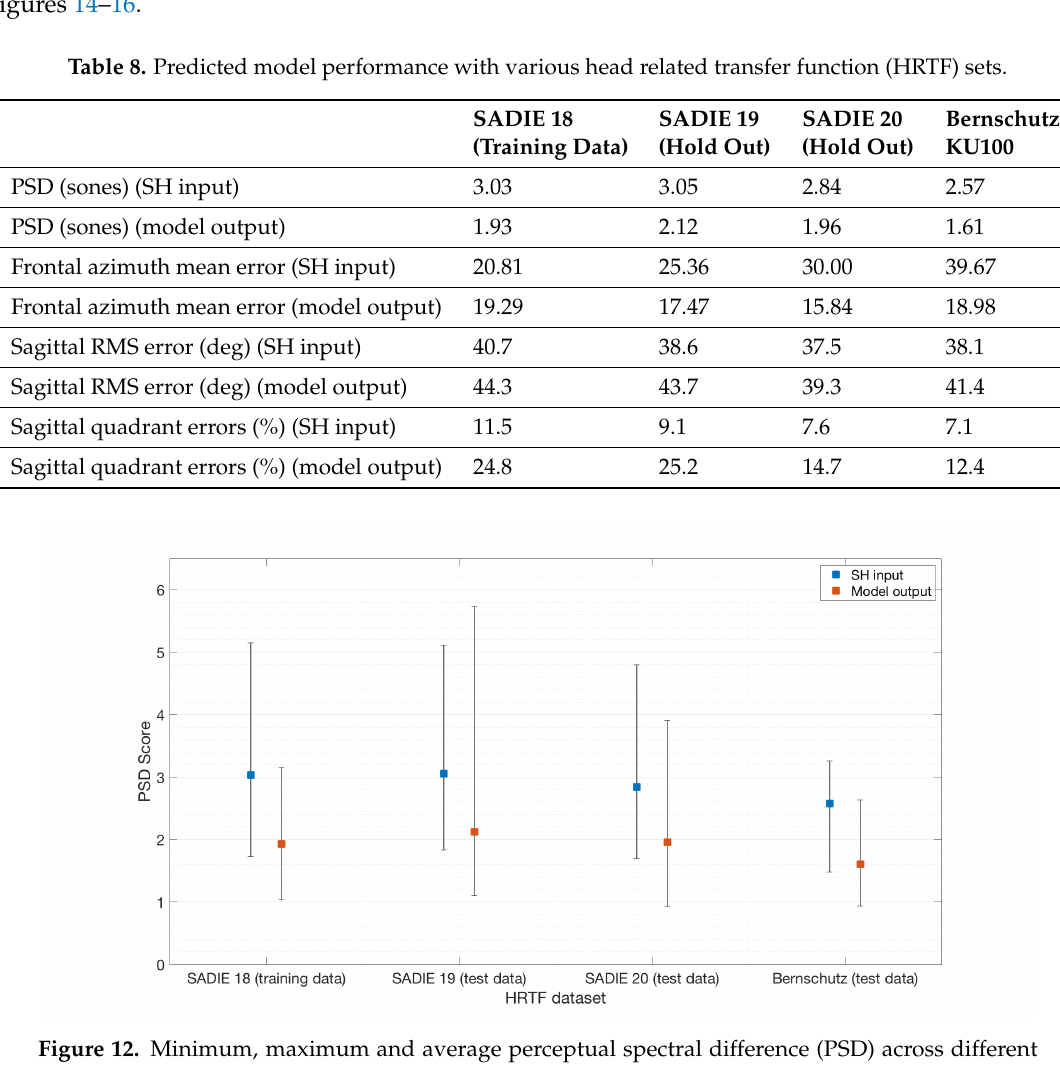
Figure 12. Minimum, maximum and average perceptual spectral difference (PSD) across different angles in different datasets which shows the model significantly improved the mean PSD from the non-reconstructed interpolated